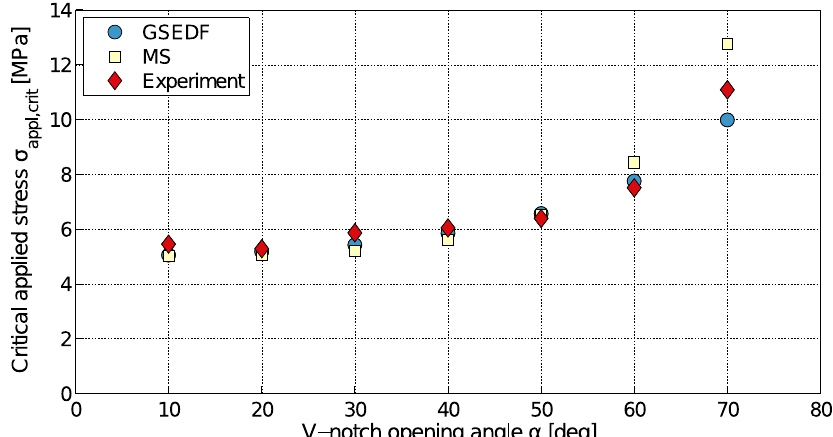
 for different V-notch opening angle  and both stability criteria: Figure 2: Estimated values of the critical applied stress , appl crit based on generalized strain energy density factor (GSEDF) and on the mean stress ahead of the V-notch (MS). Material